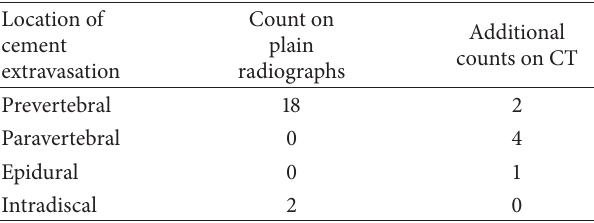
Table 3: Cement extravasations. The table shows numbers and locations of cement extravasations. Postoperative radiographs were available in all patients. Postoperative computed tomography (CT) was available in 24/35 patients (68.6%). Beside all cement extravasa- tions detected on plain radiographs, CT additionally demonstrated slight prevertebral, paravertebral, and epidural cement extravasa- tions.